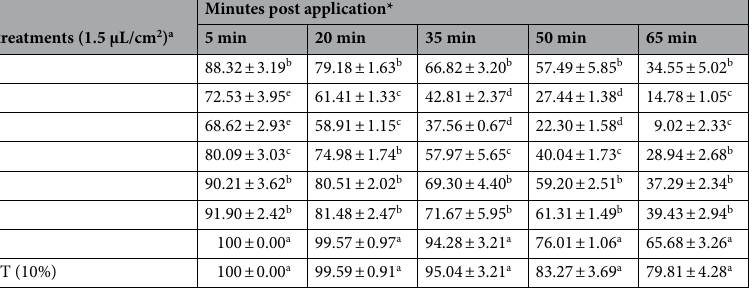
Table 2. The percentages of repellencies of seven Ar. argyi essential oils and DEET against the four-day old An. sinensis adults during different exposed times . *The repellent rates with different superscript letters in the same column are significantly different at p < 0.05. The rates were determined with three replications. CQ, SC, YN, HB, HN, SD and GS: essential oils from Chongqing, Sichuan, Yunnan, Hubei, Henan, Shandong and Gansu province/municipality, respectively.